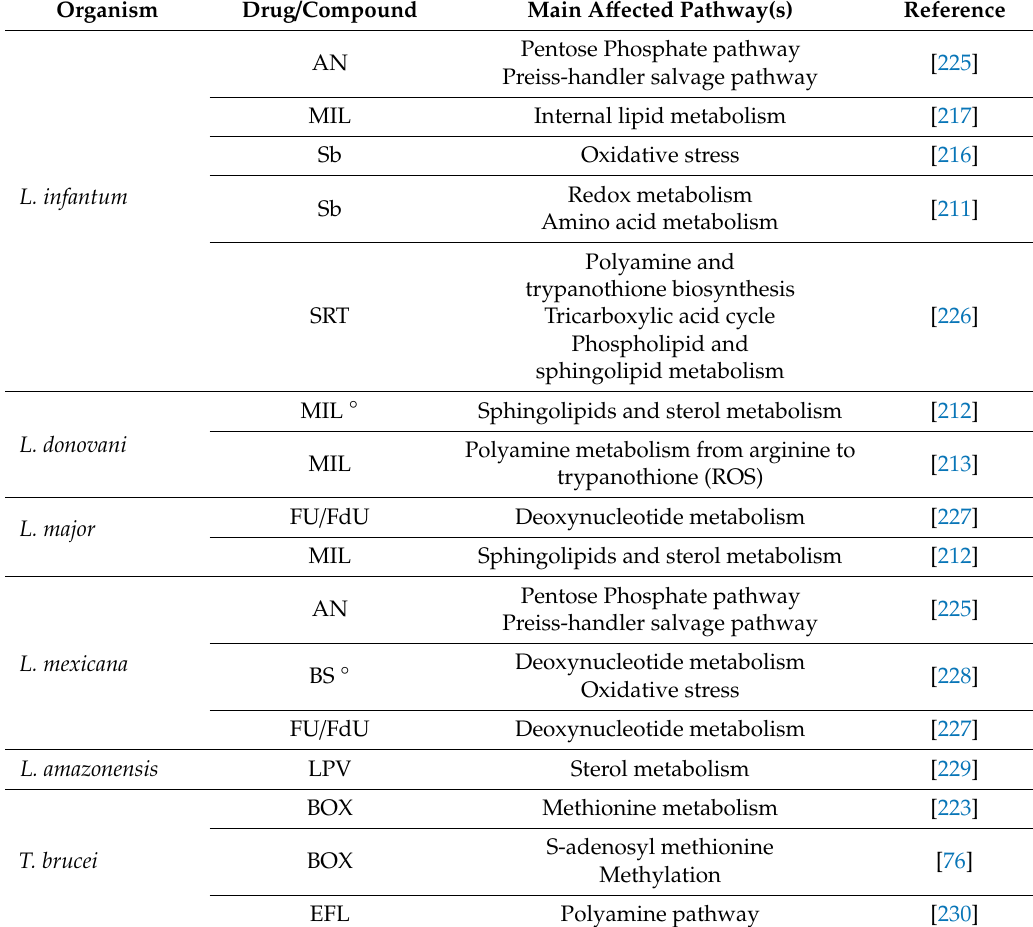
Table 6. Application of untargeted metabolomics to unravel the MoA of anti-kinetoplastid drugs. All references in this table compared the metabolome between treated and untreated samples. Experiments performed with Leishmania were performed on promastigotes unless mentioned